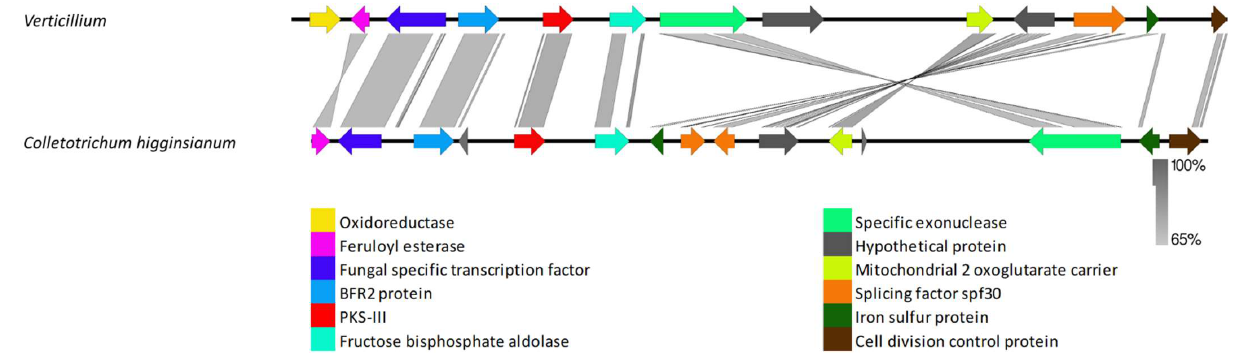
Figure 5. Comparison of Verticillium genes flanking PKS-III that are closely related homologs of PKS-III gene cluster from Colletotrichum higginsianum . The arrowheads indicate the direction of transcription and the types of genes common to the two clusters being compared are displayed in the same color. Shaded lines represent similarities between nucleotide sequences. This highly conserved cluster was found in all Verticillium genomes examined.